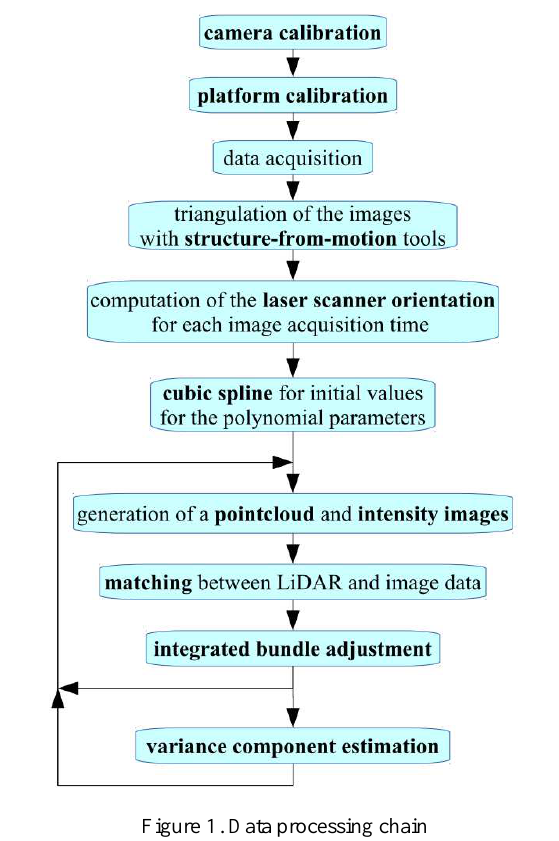
Figure 1. Data processing